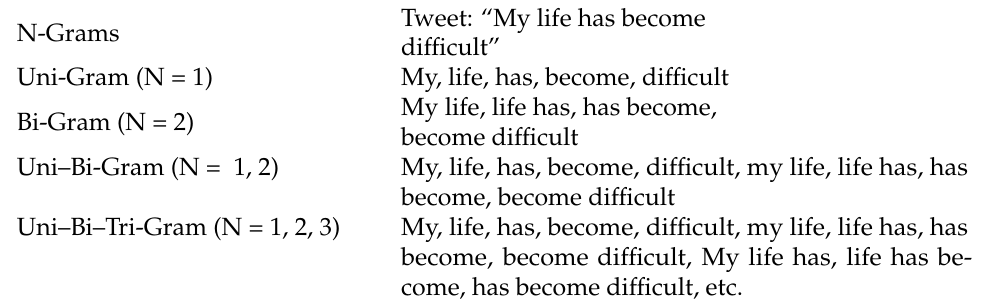
Table 5. Elaboration of